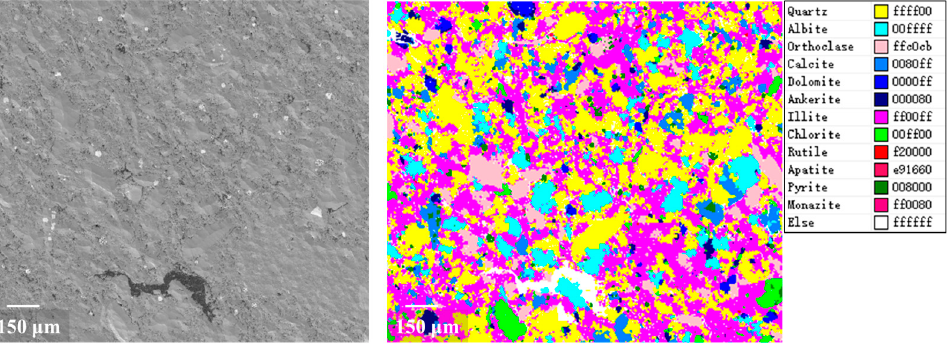
Figure 2. Measurement of particle porosity.